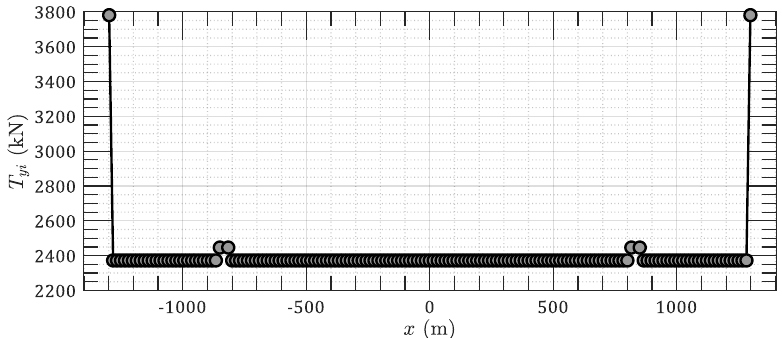
Figure 5. Hanger tension forces in y -direction along the bridge span.